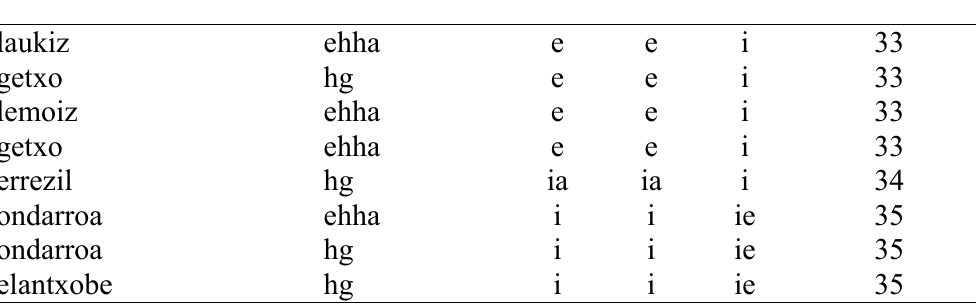
Table 10 . Summary of all the combinations attested in EHHA and